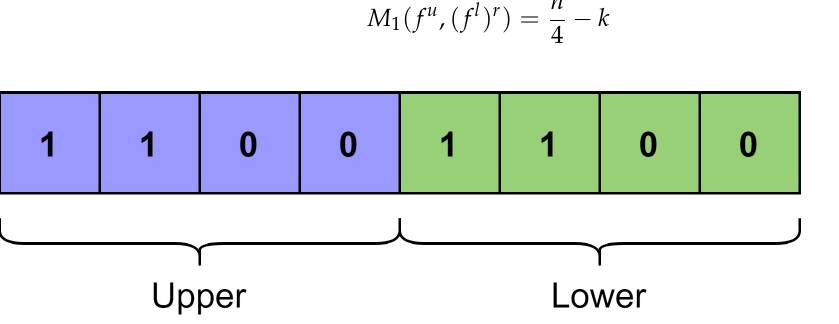
Figure 3. Concept of lower and upper halves of